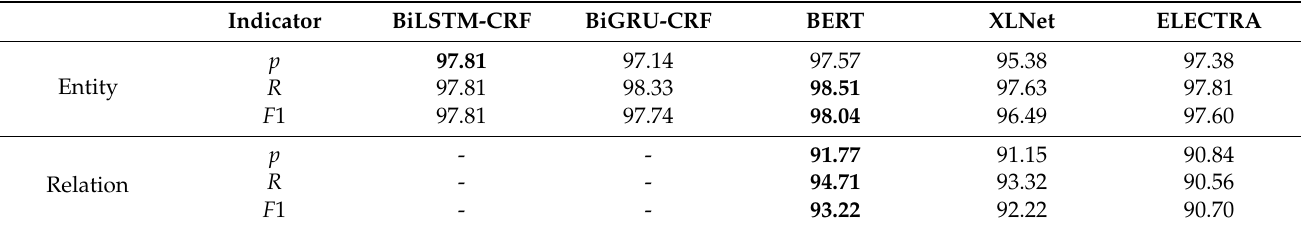
Table 4. The performance of different models in a sequence labelling task and relation extraction task. Bold marks indicate the best performance in all